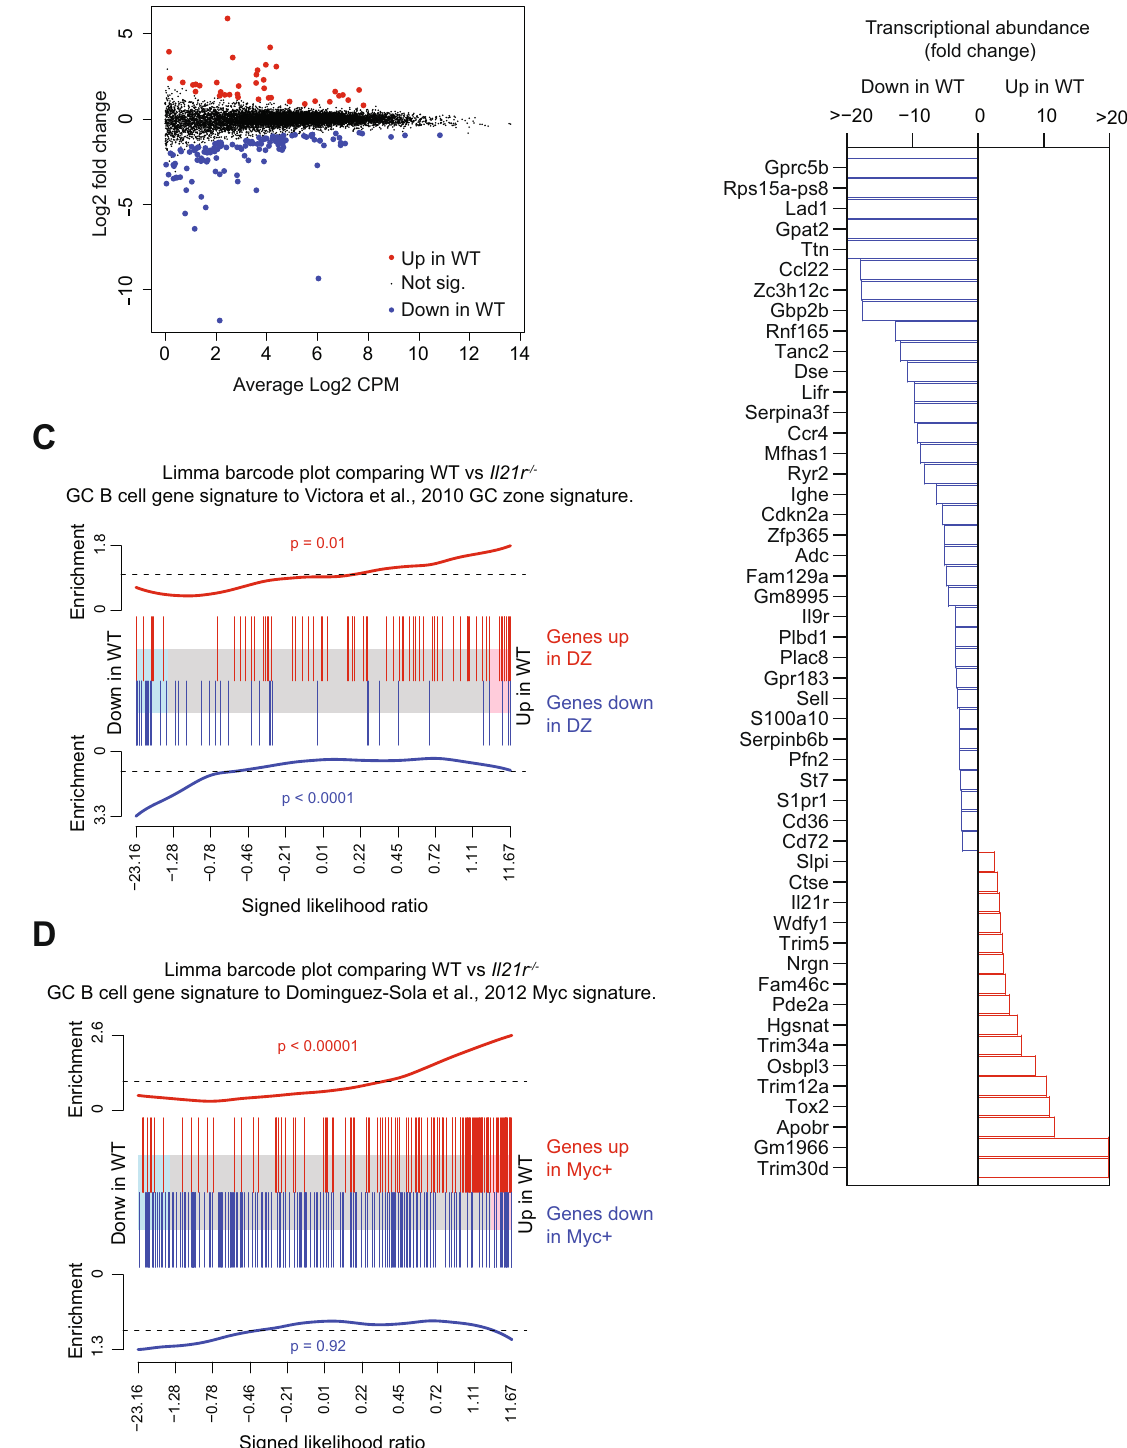
immunization i.p. with NP-KLH in alum (Supplementary Fig. 8C). Analysis of RNA-seq data revealed 164 genes to be signi fi cantly differentially expressed (DE) in WT compared to Il21r − / − GC B cells, with 126 up- and 38 down-regulated (Fig. 5A), the top 30 of each in both directions were plotted (Fig. 5B). None of the DE genes were previously identi fi ed as regulators of GC B cell behavior, such as cMyc or Foxo1 , emphasizing the normality of Il21r − / − GC and